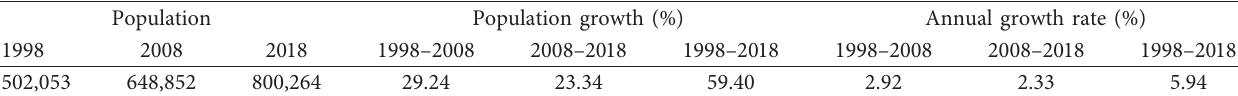
Table 6: Population of Blantyre City (source: